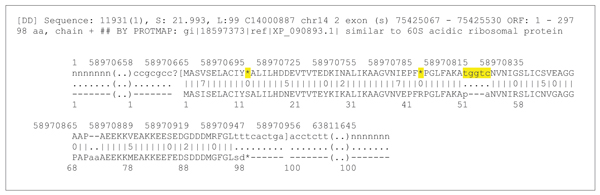
Example of a processed pseudogene. Alignment versus protein encoded by the parent gene. Identity, 83.7%; coverage of protein sequence, 93.9%; number of internal stop codons, 2; number of frameshifts, I; Ka/Ks, 0.484.